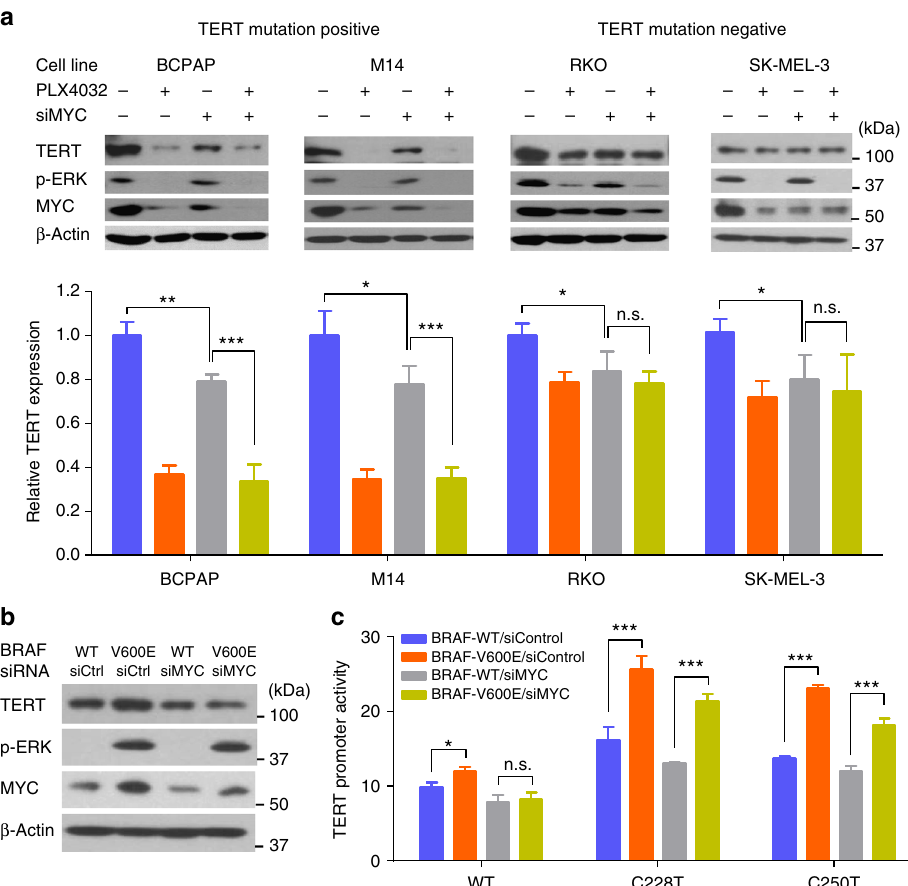
Fig. 3 MYC-regulated TERT expression in a TERT promoter mutation-independent manner. a The four indicated cancer cell lines harboring BRAF V600E mutation were treated with 0.5 μ M PLX4032 and/or 10 n M MYC-speci fi c siRNA (siMYC) for 24 h, which were then subjected to western blotting (upper panel) and qRT-PCR (lower panel). The relative TERT mRNA expression was normalized to the control group. b , c Parental and BRAF V600E knock-in SW48 cells were treated with control siRNA (siControl) or MYC-speci fi c siRNA (siMYC, 10 n M ) for 48 h, followed by western blotting ( b ) and luciferase reporter assays ( c ). * P < 0.05, ** P < 0.01, *** P < 0.001, by two-tailed Student ’ s t test. n.s. not signi fi cant. All the values represent the average ± standard deviation (SD) of triplicate samples from a typical experiment. Similar results were obtained in two additional independent